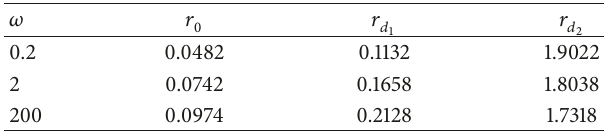
Table 3: Critical points of BD-BI theory for 𝑞 = 0.1 , Λ = −1 , 𝑛 = 4 , 𝑏 = 1 , and 𝛽 = 1.5